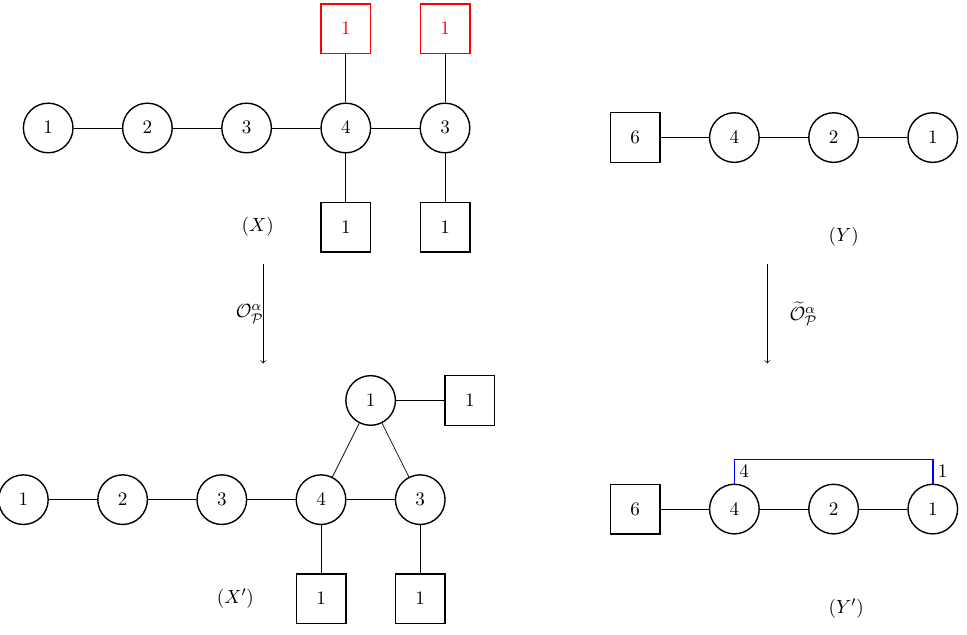
Figure 13 . The construction of the quiver gauge theory ( X 0 ) from the theory ( X ) by the action of the S -type operation O . The flavor nodes to be identified in the quiver ( X ) are shown in red. The P quiver gauge theory ( Y 0 ) is constructed from the theory ( Y ) by the action of the dual operation e O